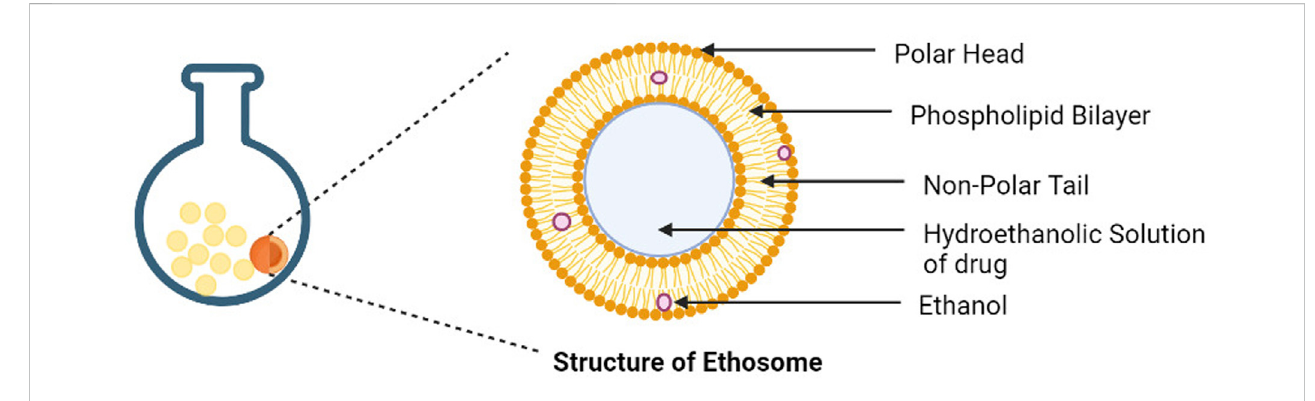
FIGURE 6 Structure of